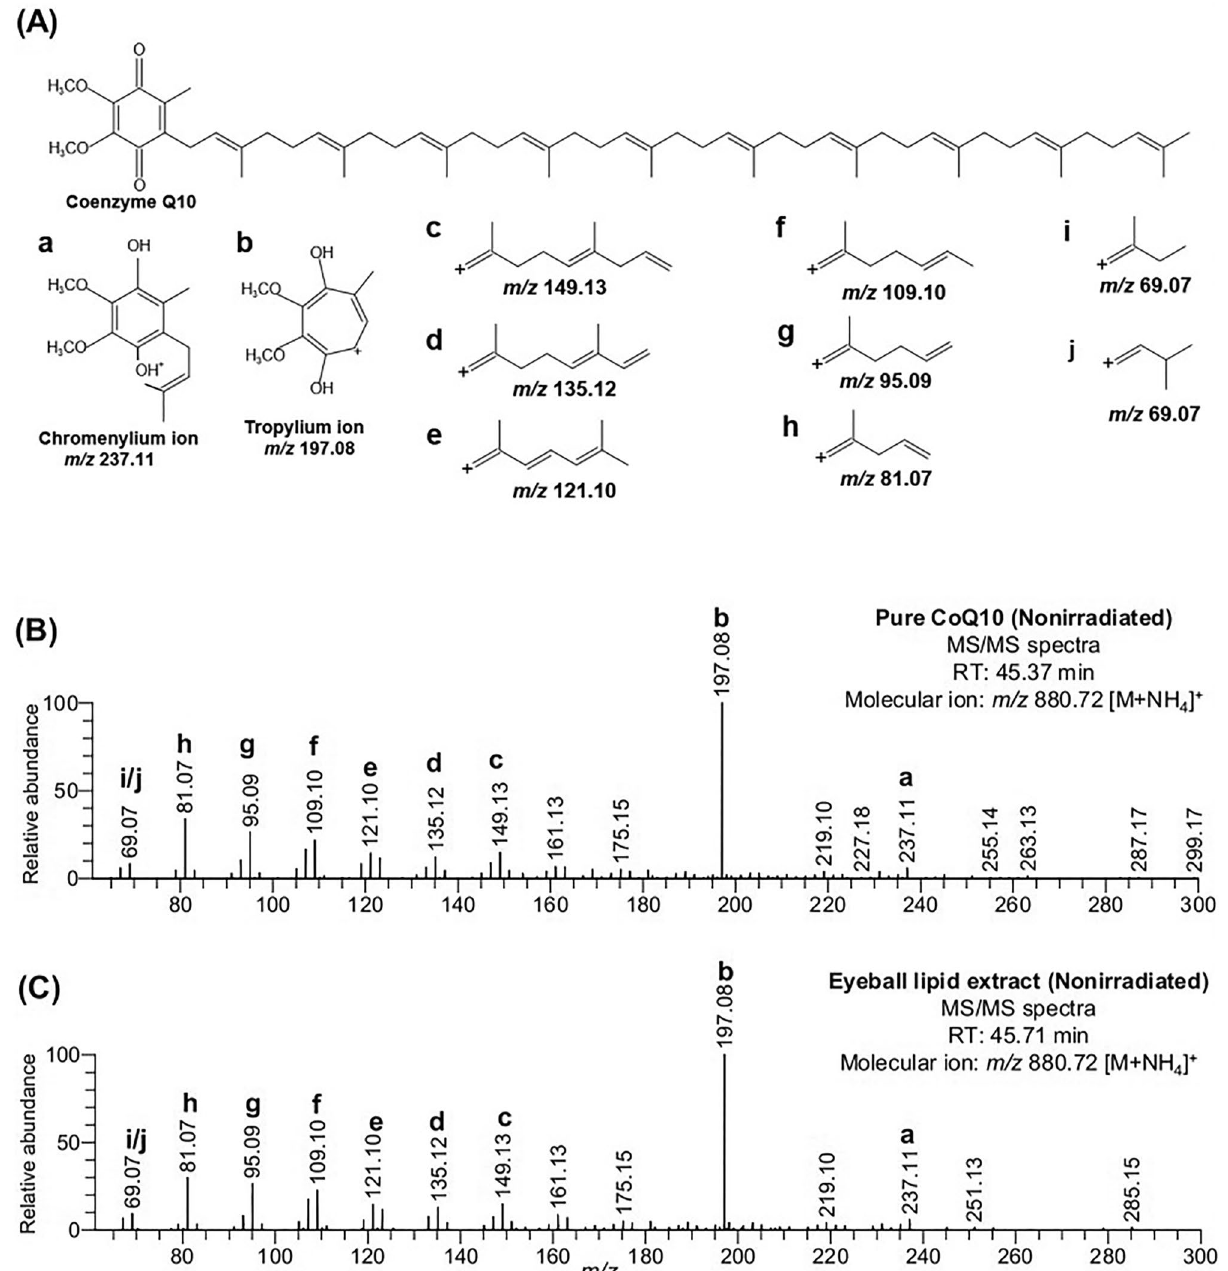
Figure 2. Structural analysis of ion at m/z 880.72. ( A ) The structure of natural CoQ10 (all- trans form) with known and possible fragment ions (a–j). ( B ) MS/MS spectra of nonirradiated pure CoQ10. ( C ) MS/MS spectra of the molecular ion at m/z 880.72 (tentatively assigned as [CoQ10 + NH 4 ] + ) were observed in nonirradiated eyeball lipid extract data. The fragments of CoQ10 shown in ( A ) were marked in the MS/MS